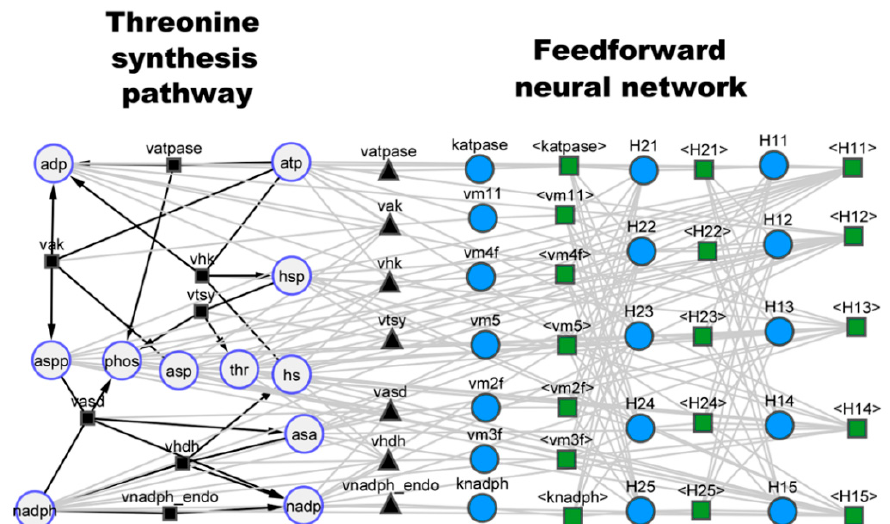
Figure 2. Hybrid model structure [11 × 5 × 5 × 7] for the threonine synthesis pathway (1st row of Table 2) visualized in the cy3sbml tool [43]. Left side : Metabolic network with physical meaning. Large circles represent biochemical species (metabolites). Black squares and black edges represent biochemical reactions. Black triangles represent kinetic laws. Right side : Artificial feedforward neural network with size [11 × 5 × 5 × 7]. Small blue circles represent neural network nodes. Green squares and gray edges represent signal propagation between neural network nodes. The first layer receives input signals of biochemical species concentrations (Large circles). The last layer delivers kinetic parameter values to the black triangles, which mediate the communication between both sides of the network.